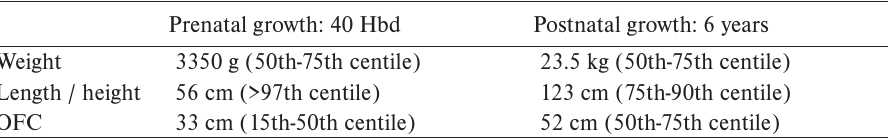
Table 3. Growth parameters of patient AB (with mutation in NFIX gene).